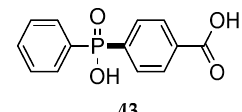
Figure 19. Chemical structure of compound 43 .